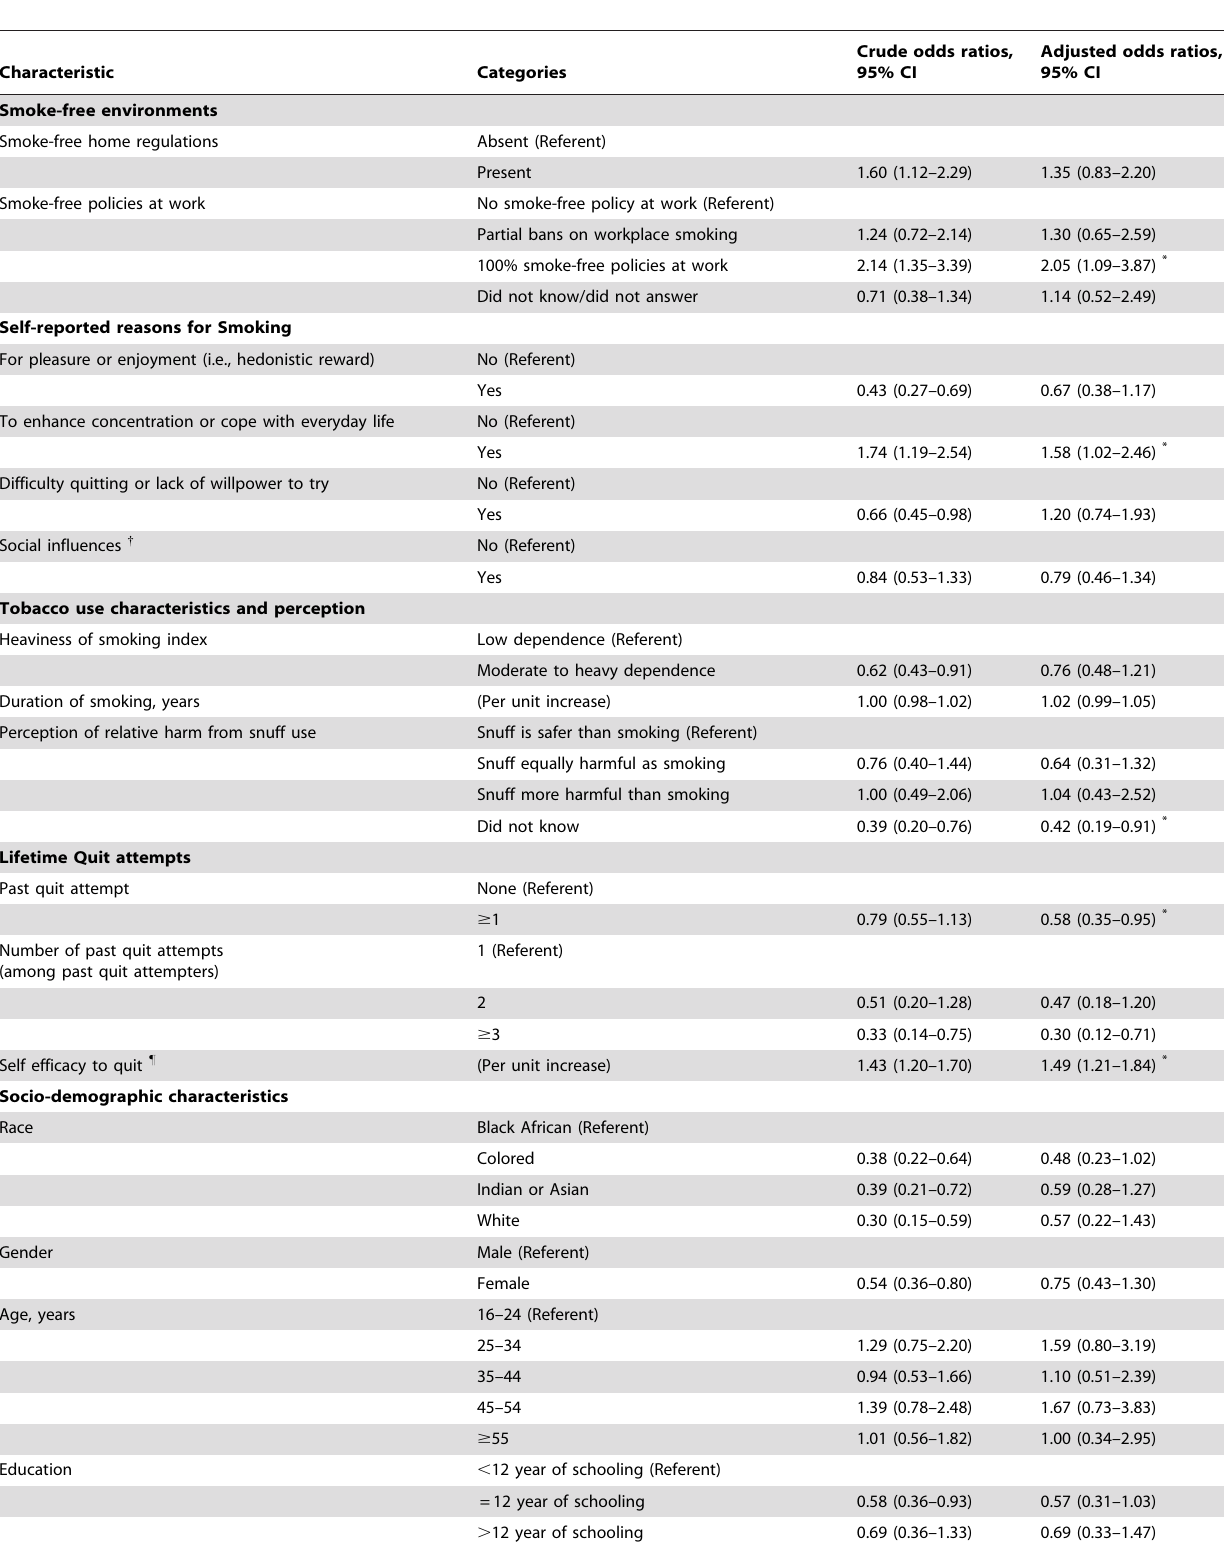
Table 4. Logistic regression analyses of factors associated with interest in harm reduction switching to snuff among current exclusive cigarette smokers ( n =678), South African Social Attitudes Survey,